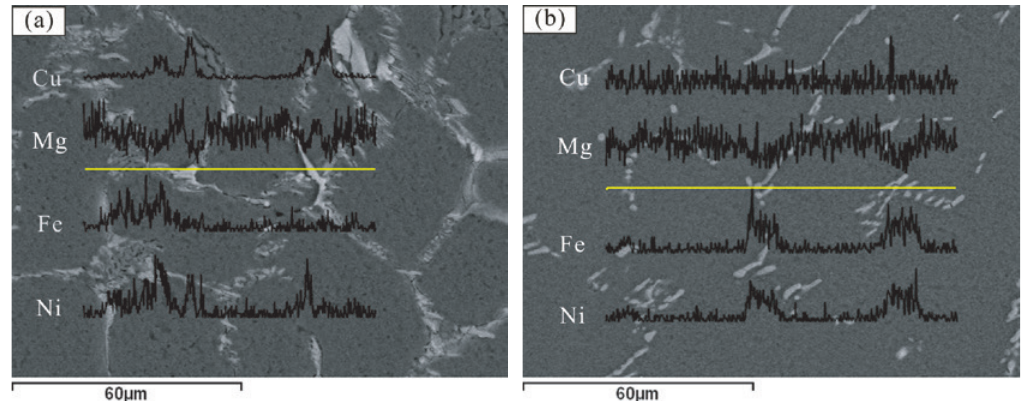
Fig. 6: Line-scan analysis of elements in alloy 2618 before and after homogenization: (a) as-cast; (b) homogenized at 500 °C for 16